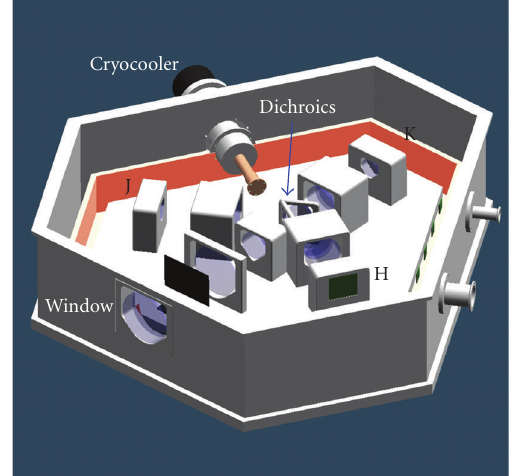
Figure 12: The cryomechanical scheme for the NIR